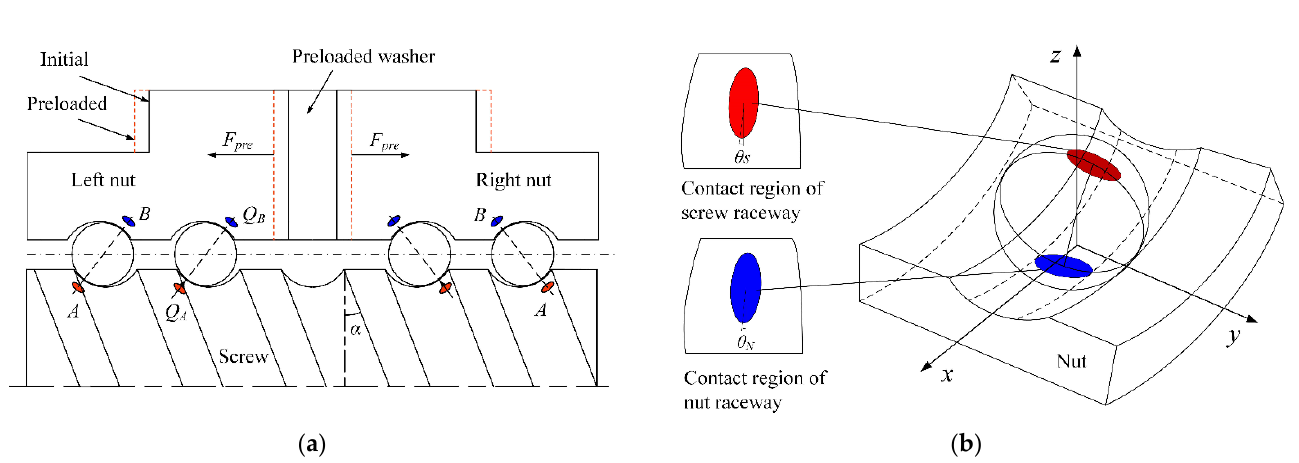
Figure 1. Force analysis of ball screws. ( a ) Force balance analysis. ( b ) Contact mechanics analysis.